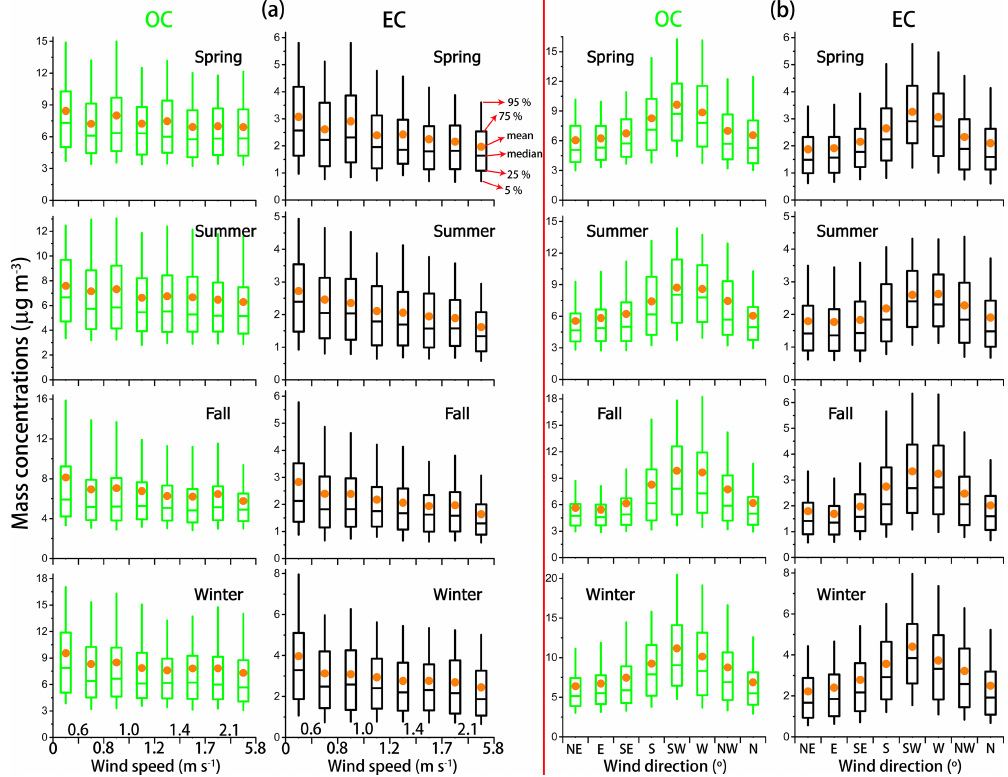
Figure 13. Box plots of OC and EC mass concentrations as a function of wind speed increments (a) and wind direction sectors (b) between July 2010 and December 2014 in Shanghai. The mean, median, 5th, 25th, 75th, and 95th percentiles are indicated in the second figure of the top row.